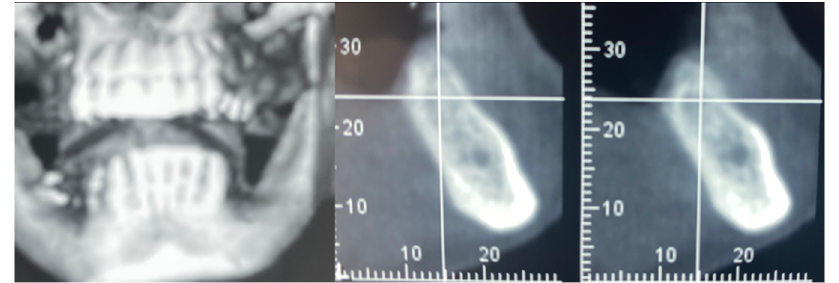
Figure 8. New volume observed 8 months after surgery.